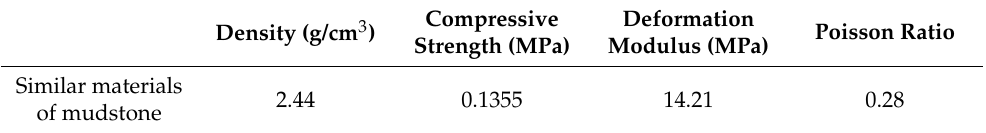
Table 5. Physical and mechanical indexes of similar materials for